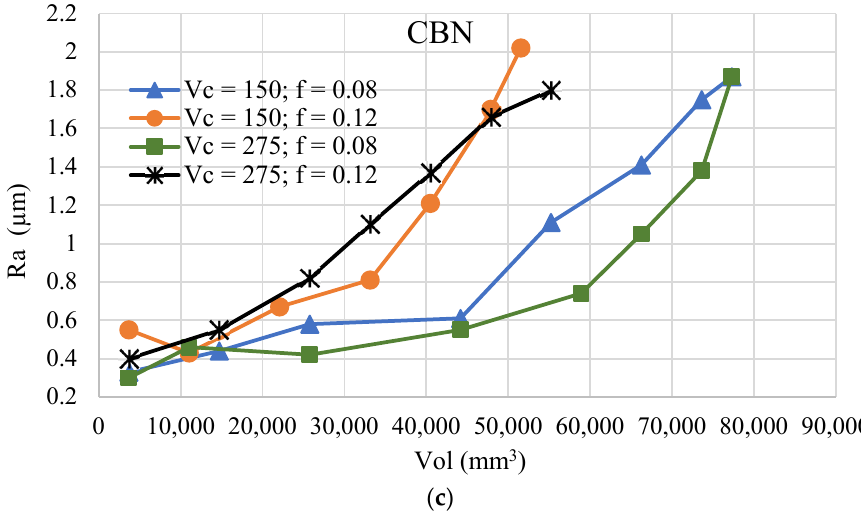
Figure 3. Progress of average arithmetic surface roughness with volume of work material removed, categorized with respect to the three cutting inserts used in the experiments: ( a ) uncoated carbide; ( b ) coated carbide; and ( c ) CBN. V c and f are represented in m/min and mm/rev, respectively.